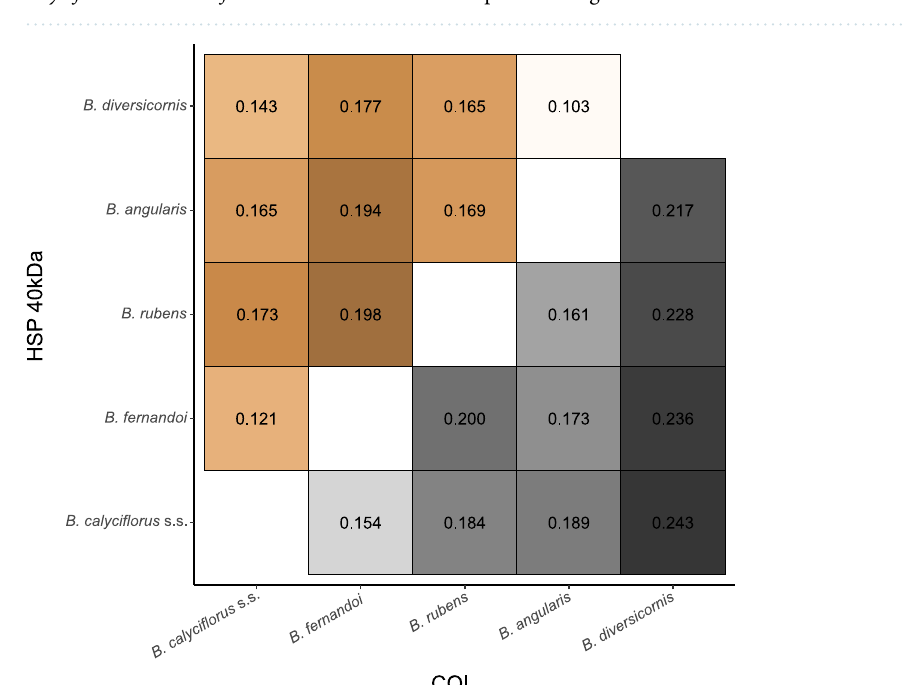
comparison of non-synonymous (dN) vs. synonymous (dS) substitutions in the HSP 40 kDa gene yielded an overall dN/dS: 0.049, with the the highest dN/dS ratio between B. angularis and B. diversicornis (0.085), while the lowest one was found between B. calyciflorus s.s. and B. diversicornis, followed by B. calyciflorus s.s. and B. fernandoi (0.040 and 0.042, respectively) (Supplementary Fig. s4). Structural variation in HSP 40 kDA between B. calyciflorus s.s. and B. fernandoi . We produced 88 genomic HSP 40kDA gene sequences for our two focus species ( B. calyciflorus s.s., n = 50; B. fernandoi , n = 38) by polymerase chain reaction (PCR). The network approach based on all 88 phased sequences identified 32 unique HSP 40 kDa alleles (corresponding to 27 unique protein sequences) from which 13 alleles were exclu- sively found in B. fernandoi specimens and 19 alleles were solely found in B. calyciflorus s.s. specimens (Fig. 3).